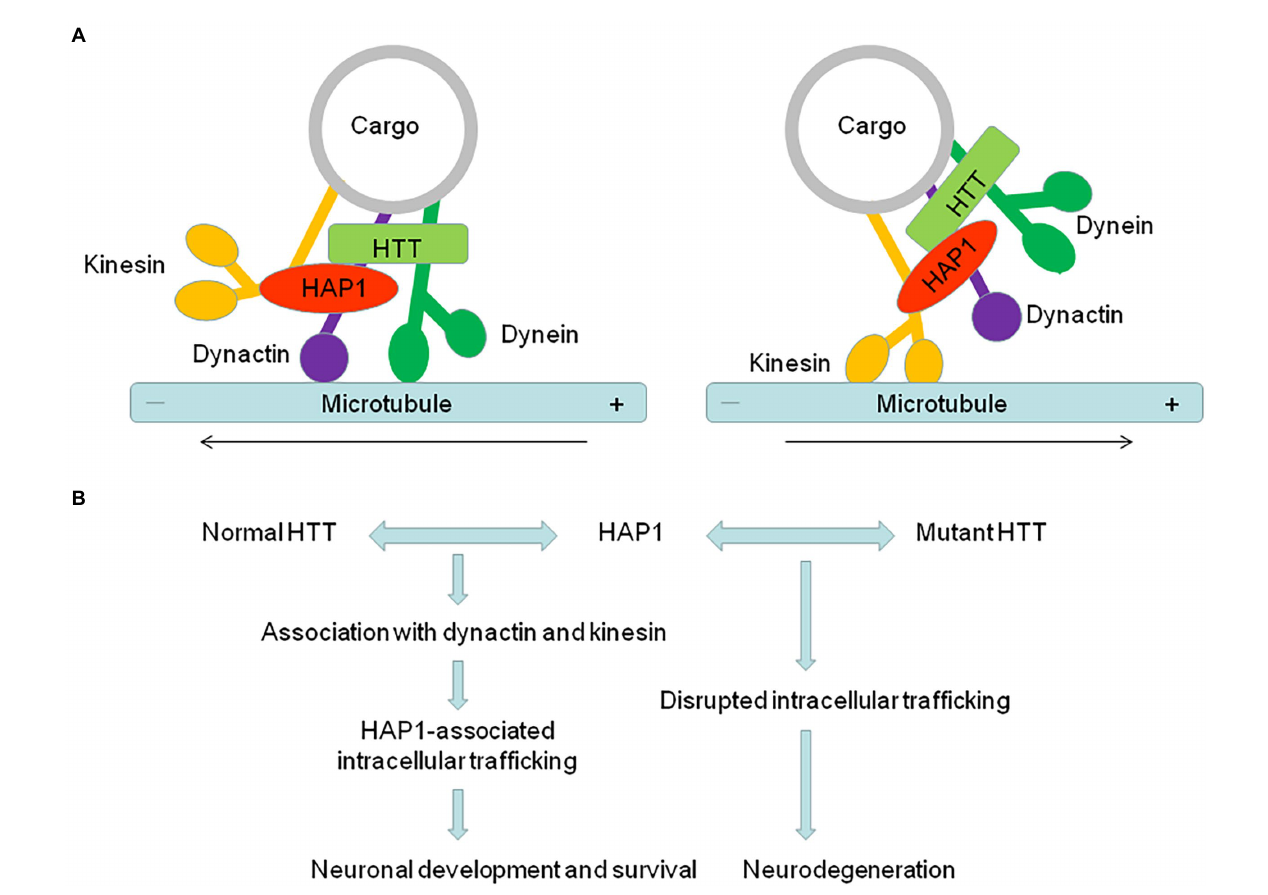
FIGURE 1 The abnormal interaction of HAP1 with mutant HTT is an important contributor to the pathogenesis of neurodegeneration in HD. (A) HAP1 is involved in intracellular trafficking via its interaction with dynactin and kinesin. The dynactin complex promotes retrograde trafficking, while kinesin promotes anterograde trafficking. (B) HAP1-dependent intracellular trafficking important for neuronal functions is affected by the abnormal interaction of HAP1 with mutant HTT, therefore resulting in neurodegeneration in